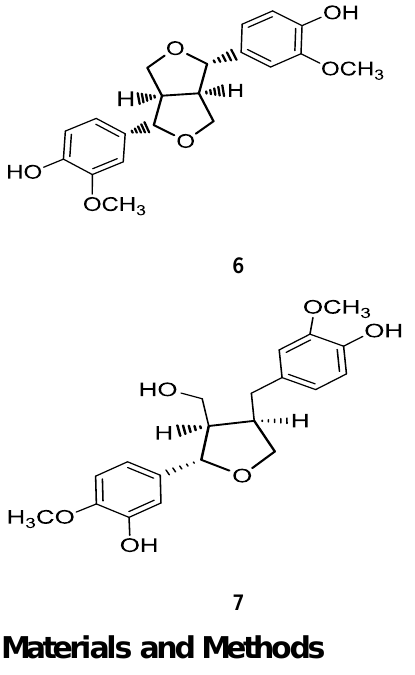
Table (1): Inhibition zones of bacterial growth produced by HMR lignan Microorganisms